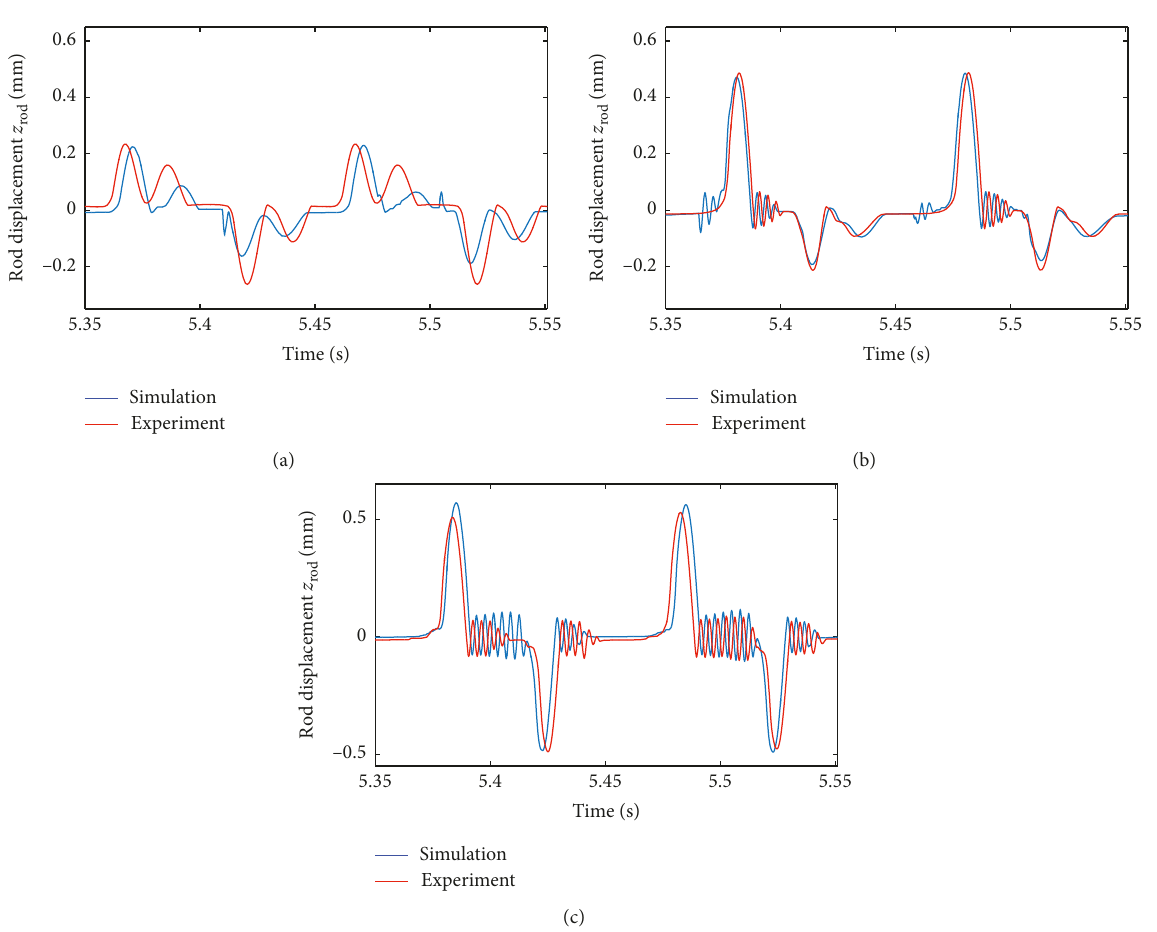
� 0.2, (b) c � 0.5, and (c) c � r r